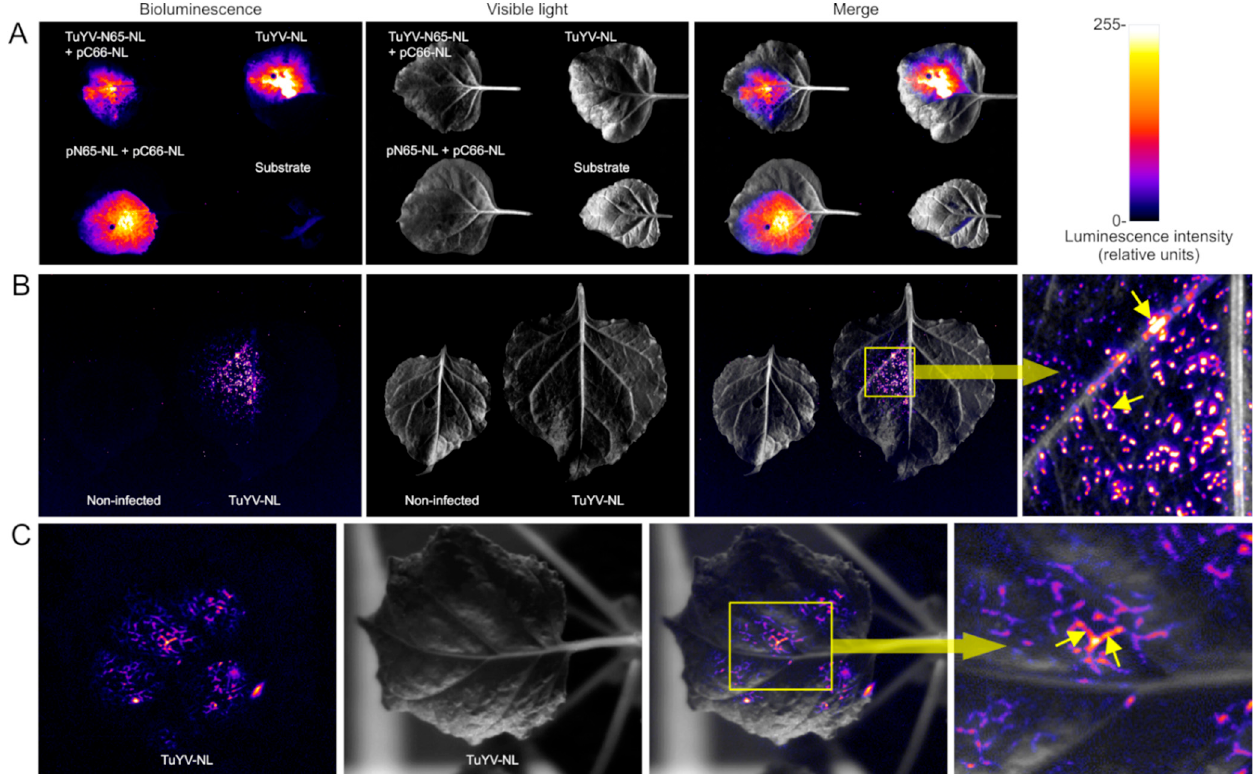
Figure 4. Detection of TuYV ‐ NL and TuYV ‐ N65 ‐ NL bioluminescence in wild ‐ type Nicotiana ben ‐ thamiana plants after infiltration of Nano ‐ Glo substrate. ( A ) Nano ‐ Glo substrate was injected in the inoculated leaf five days after agro ‐ infiltration with TuYV ‐ N65 ‐ NL and a plasmid expressing C66 ‐ NL from a 35S promoter (to allow the self ‐ assembly of functional NanoLuc) or after agro ‐ infiltration of TuYV ‐ NL. As a positive control, leaves were agro ‐ infiltrated with plasmids expressing N65 ‐ NL and C66 ‐ NL from 35S promoters (pN65 ‐ NL + pC66 ‐ NL), and as a negative control, Nano ‐ Glo was